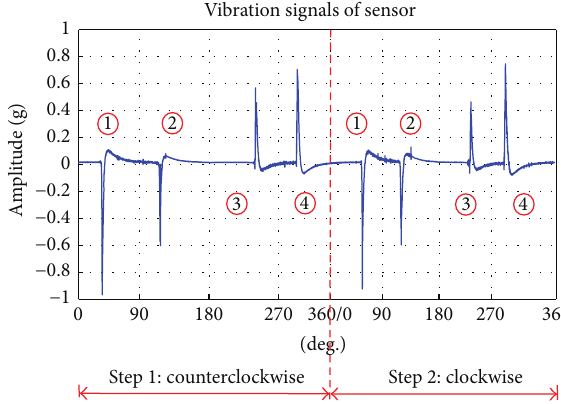
Figure 4: Signals from sensor movement